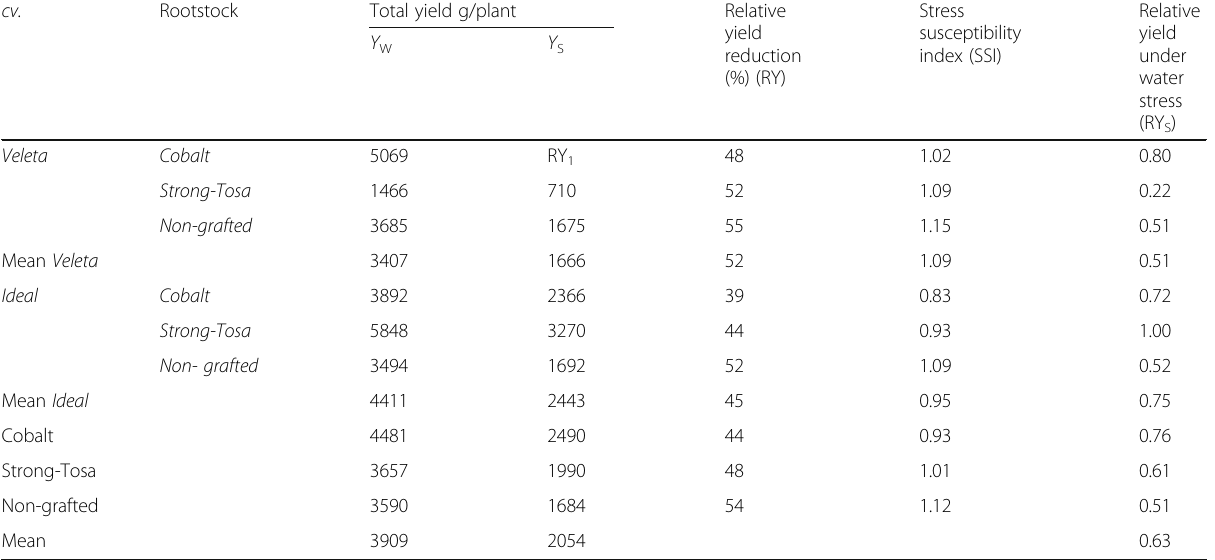
Table 6 Average yields of grafted and non-grafted cantaloupe plants (based on the average of two seasons) under normal ( Y w) and stress ( Y s) conditions, stress susceptibility index (SSI), relative yield reduction, and relative yield under water stress (RY S )